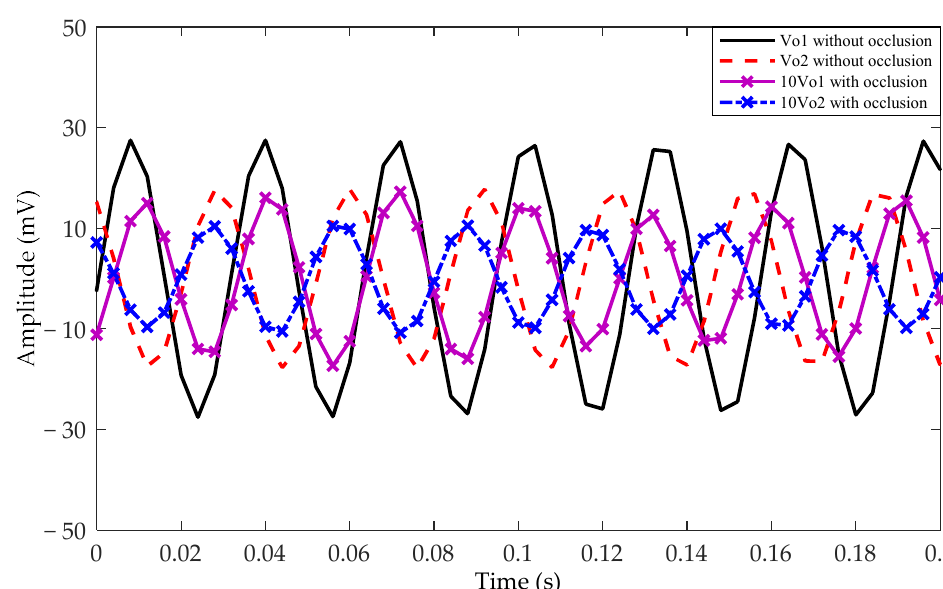
Figure 16. Comparison of the experimental waveforms with and without occlusion.